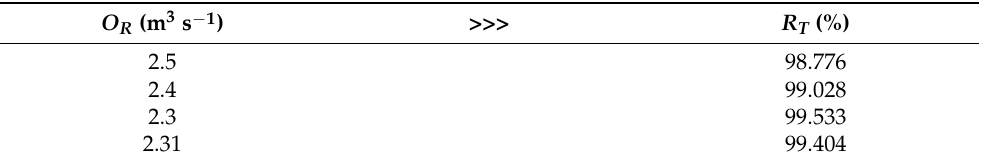
Table 1. Temporal reliability R T results for changing input O R for the updated data regarding water inflow into the